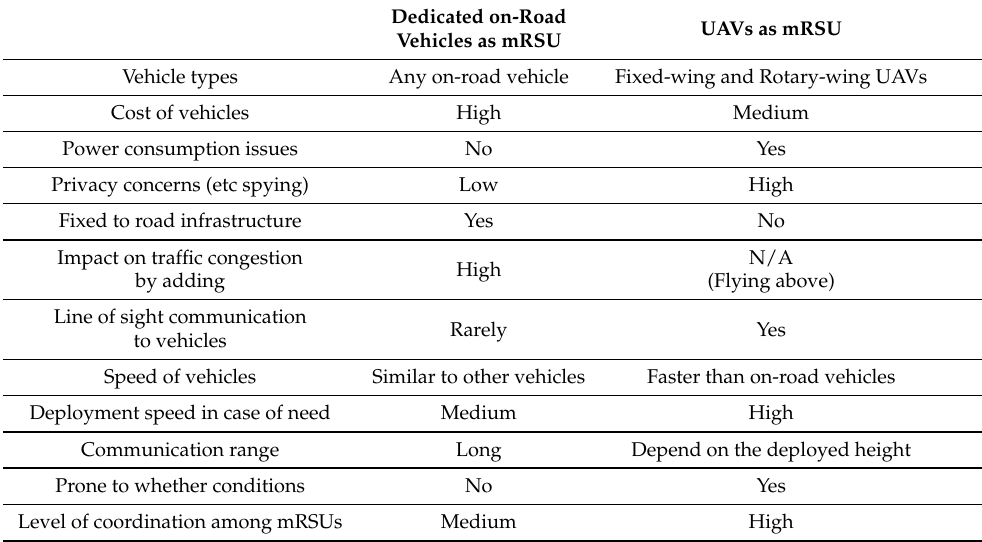
Table 2. Comparison of using additional vehicles as mRSUs.